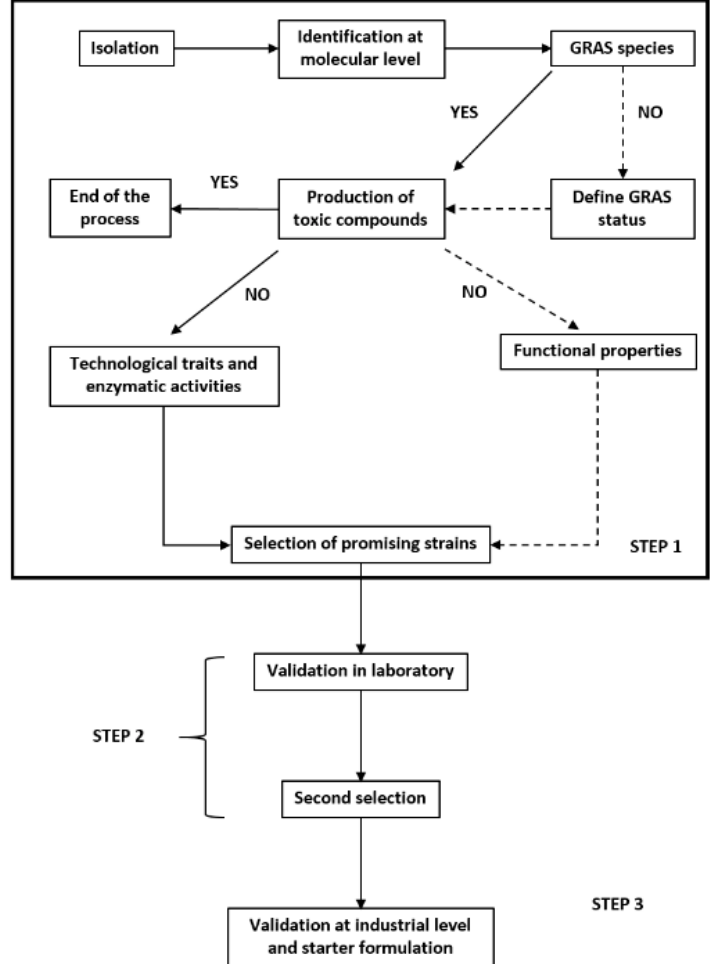
Figure 2. Flow-sheet for the selection of a starter [216]. Dotted line is for facultative paths. Conflicts of Interest: The authors declare no conflict of interest.